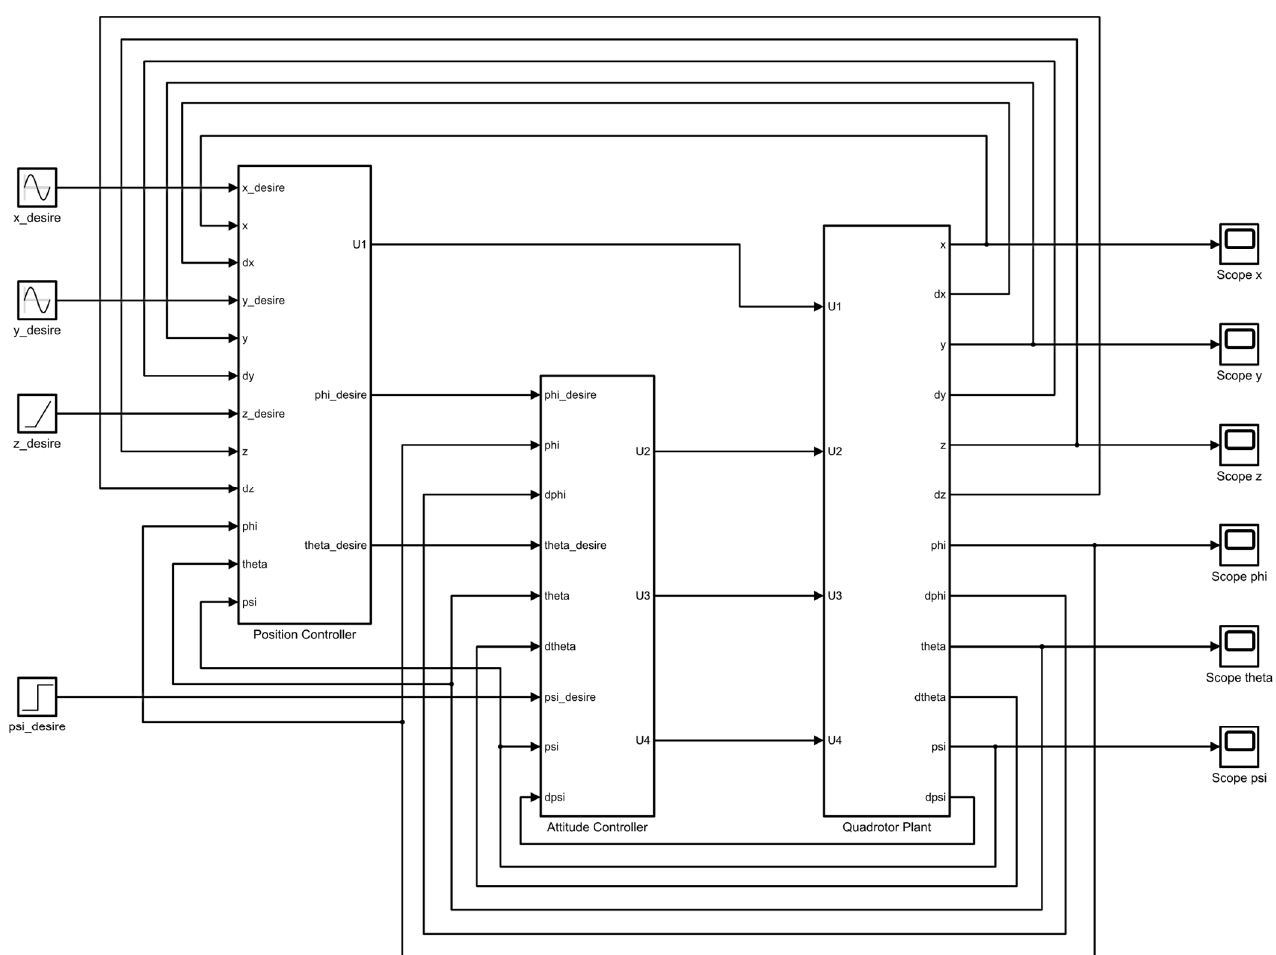
Figure A1. Simulink diagram of the closed-loop quadrotor UAV system with the proposed neural network-based adaptive fractional-order backstepping controller.